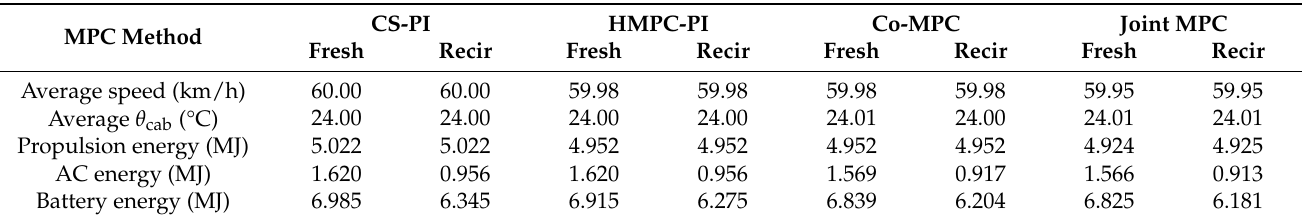
Table 4. Performance of the four methods in the second case